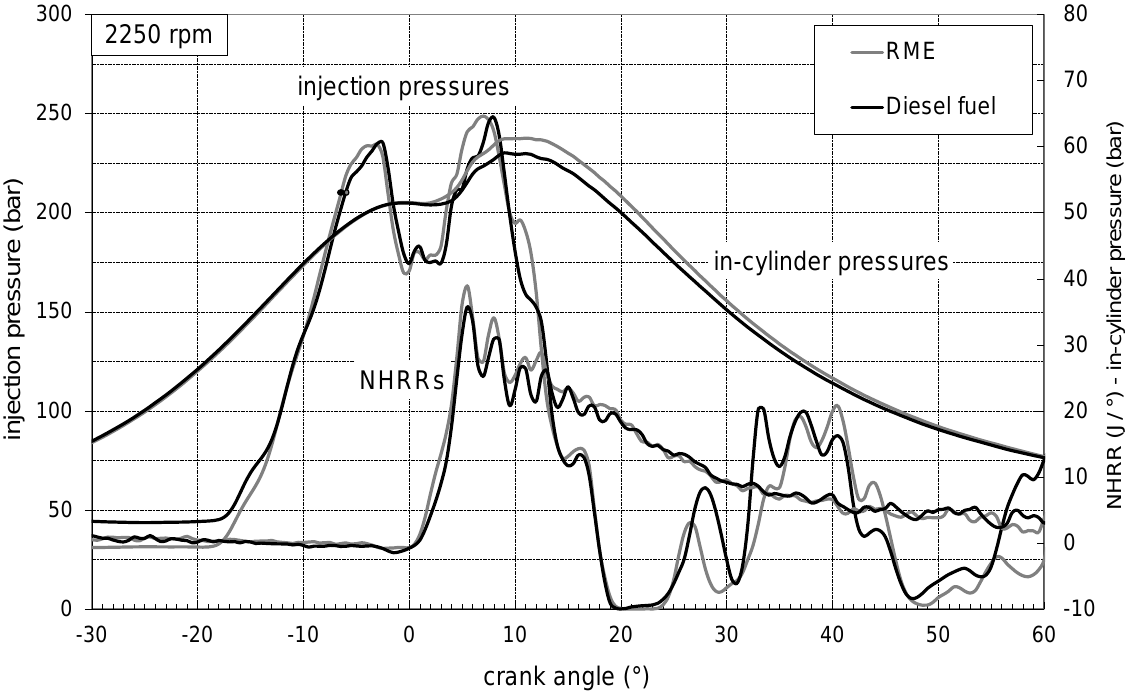
Figure 8. RME and diesel fuel injection pressures, in-cylinder pressures, and NHRR at 2250 rpm and at full load.